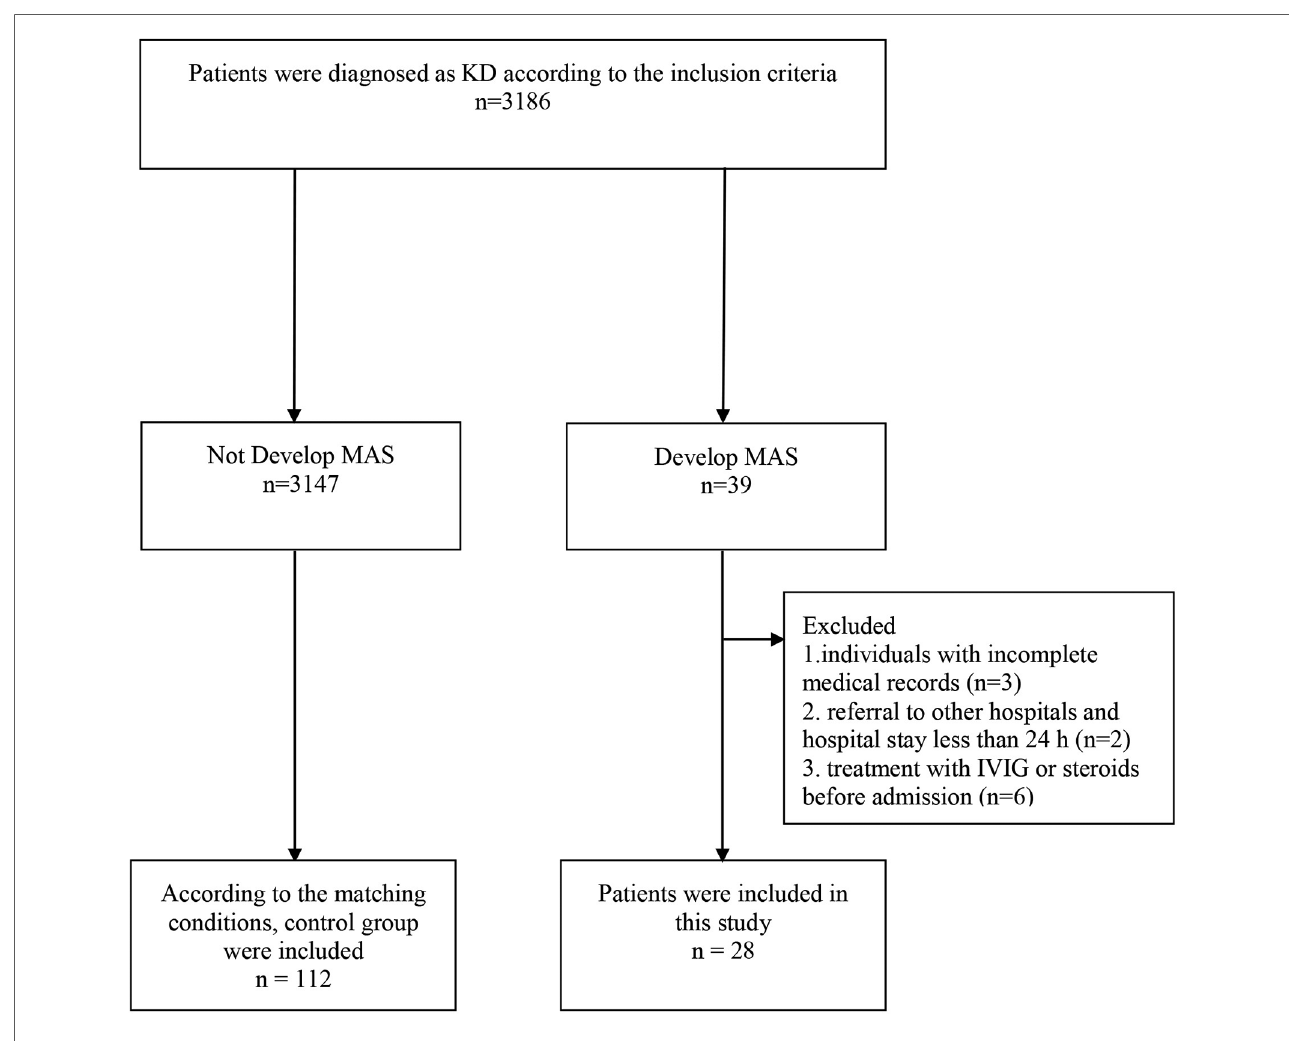
FIGURE 1 the fl ow diagram of patients included in the study